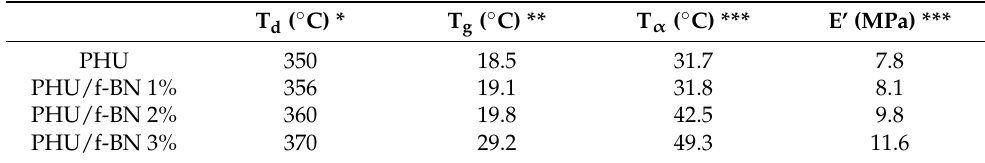
Figure 4. Thermogravimetric analysis (TGA) curves of different thermoplastic PHU films. Table 1. Different parameters of all PHU films.